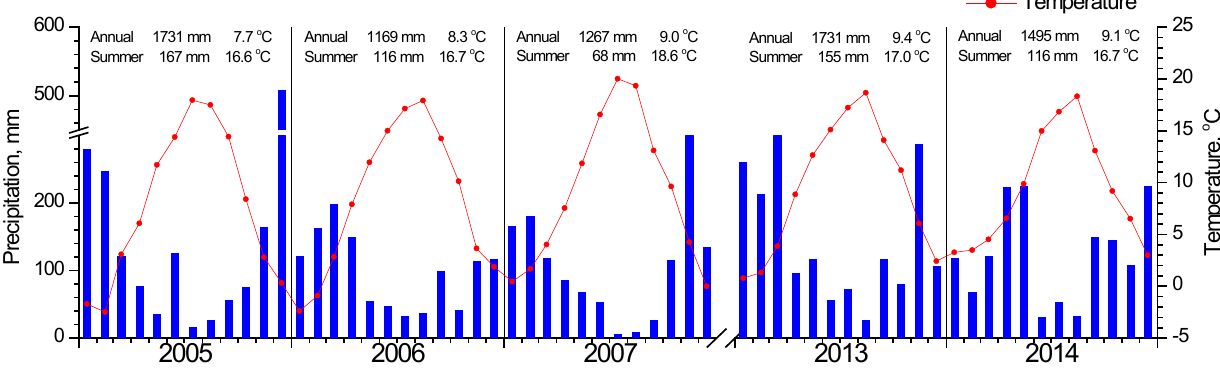
Figure 2. Meteorological data for the studied years. Average monthly temperature is indicated with the red circles and total monthly precipitation with blue bars. The annual and summer (June, July, August) total precipitation and average temperature are shown at the top of each year graph.